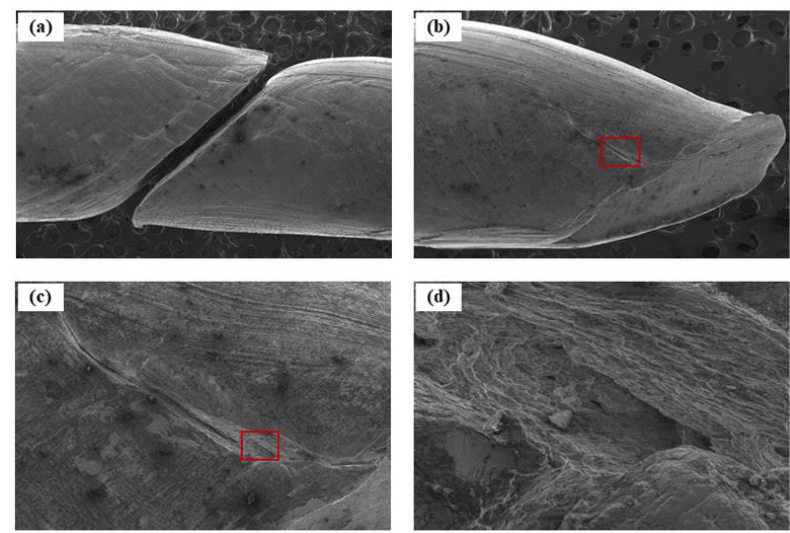
Figure 10. SEM micrographs of DTE fragment surface near the fracture region in the FGM Cu: ( a ) Fracture region between Frag. 1 and Frag. 2. ( b , c ) Fragment surface of Frag. 2 indicates crack propagation at shear localization site marked by red. ( d ) Cleavage planes along the failure region indicated in ( c ).